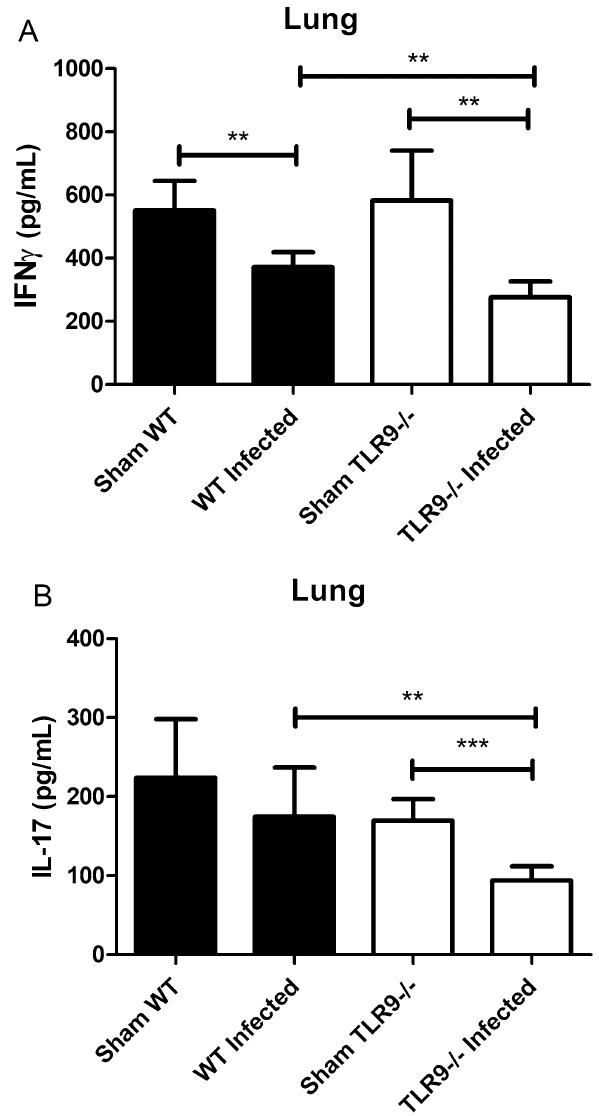
Figure 5. Levels of IFN-γ and IL-17 in total lung homogenates of C. gattii -infected mice. Measurement of IFN-γ and IL-17 levels by ELISA of total lung homogenates of WT and TLR9 −/− mice, infected with C. gattii or given PBS, after 21 days. ( A ) Dosage of IFN-γ and ( B ) IL-17. The graphs show a representative result of two similar and independent experiments. Sham WT (n = 4), Sham TLR9 −/− (n = 4), infected WT (n = 6), infected TLR9 −/− (n = 7). **P < 0.005; ***P < 0.001; ns = not statistically